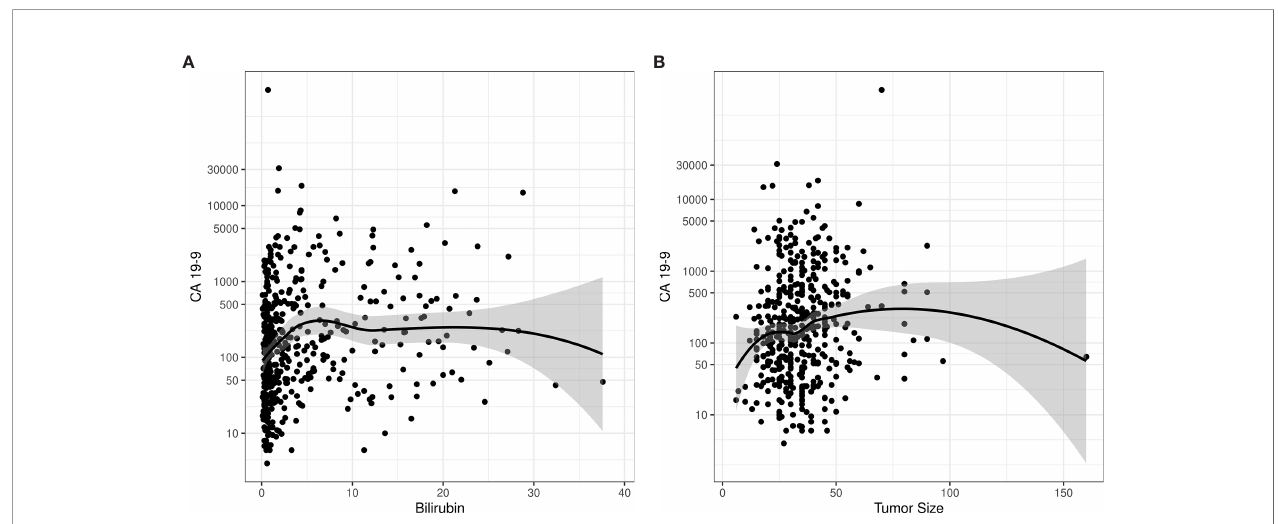
FIGURE 2 | Loess curves demonstrate a lack of correlation between CA 19-9 levels and (A) bilirubin and (B) tumor